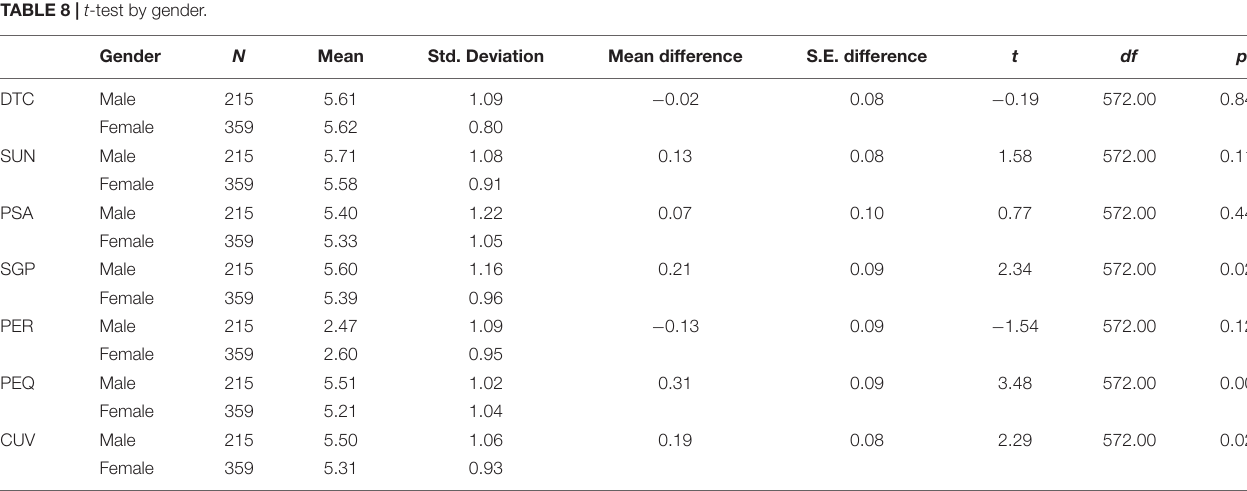
TABLE 8 | t -test by